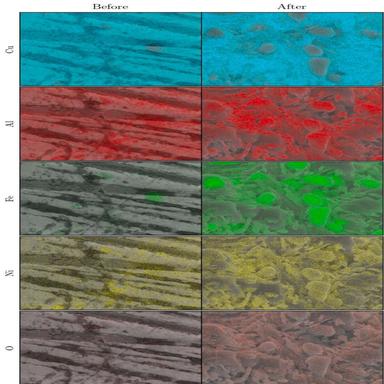
EDS surface composition images of a representative lithium-exposed small aluminum bronze sample. Copper is depleted in regions with heightened Fe concentrations. Ni-Al compounds seem to form in the surface, similar to the silver-plated 316 stainless steel. Oxygen present on the surface is most likely signifying the formation of lithium-oxide in the surface.